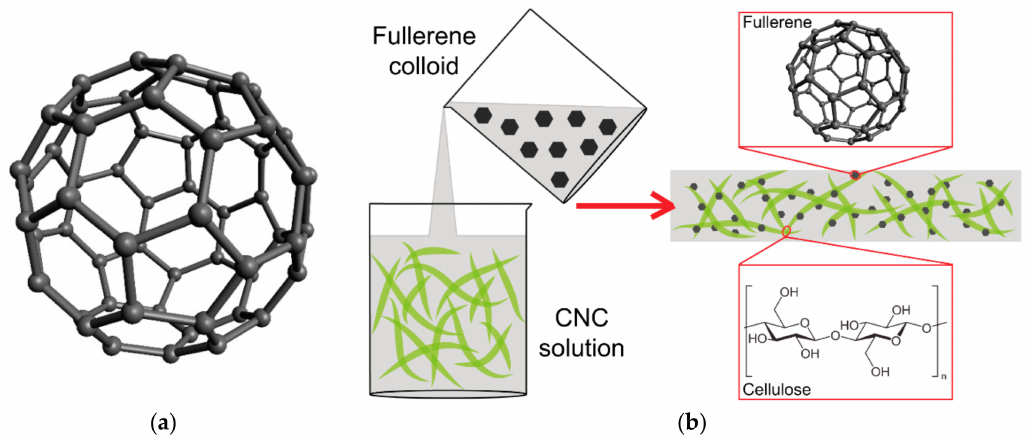
Figure 1. Scheme of fullerene C 60 ( a ) and of the preparation and structure of nanocellulose / fullerene composites ( b